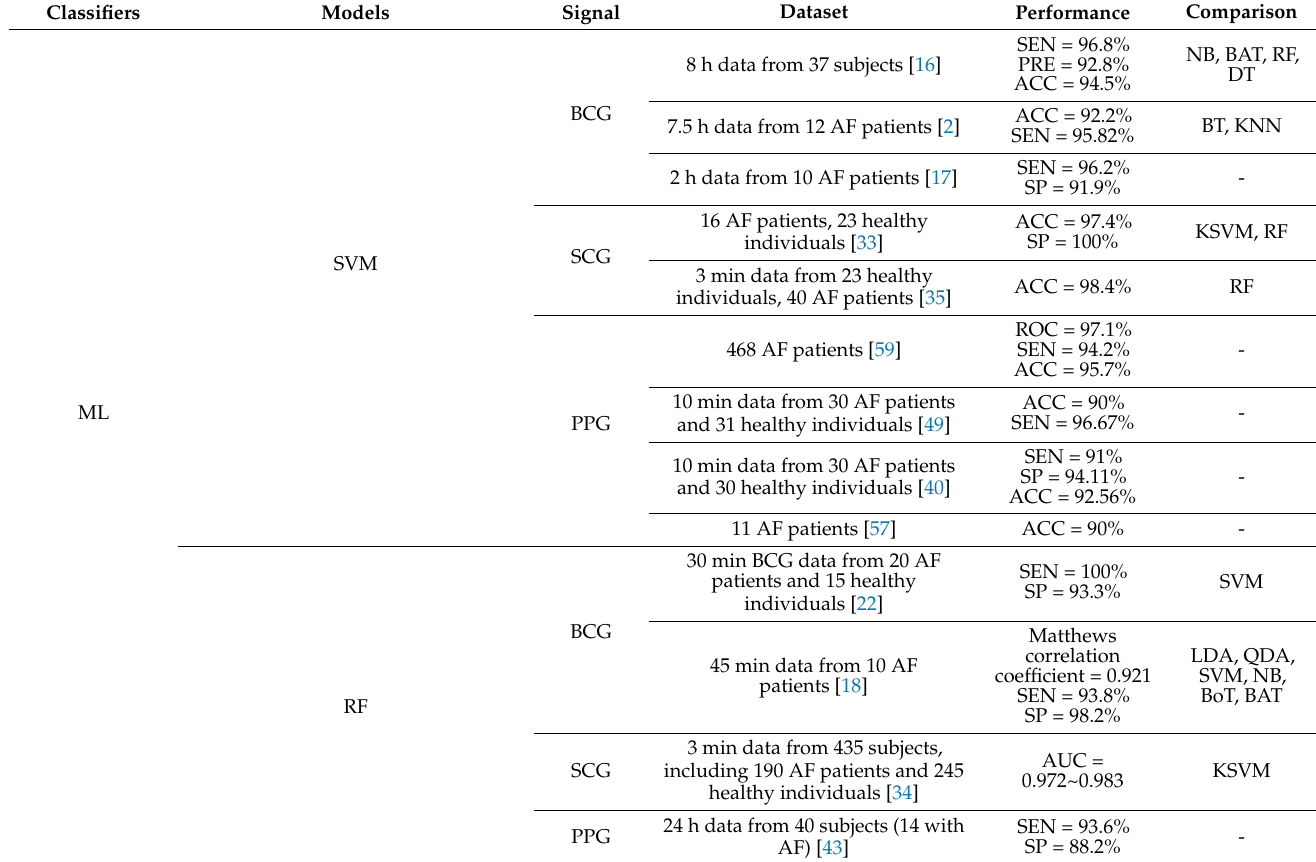
Table 3. Classifier for AF detection using cardiac dynamics